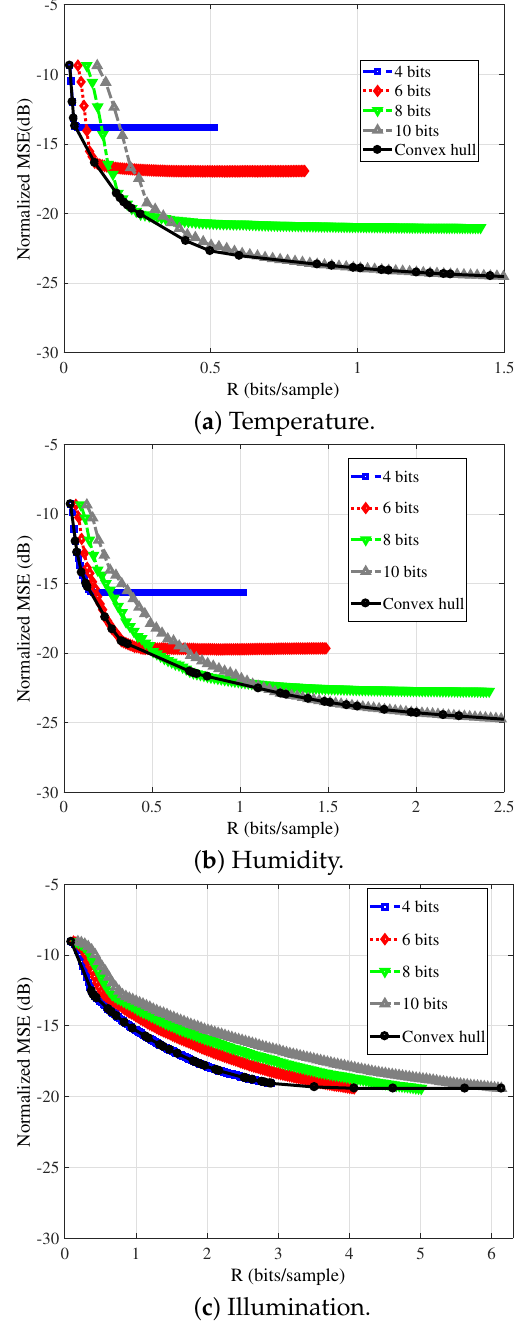
Figure 3. Rate-distortion curves and convex hulls for the reconstruction of signals with LASSO for several quantization bit-depths. The block length N is equal to